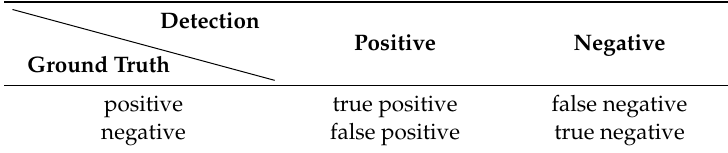
Table 2. Performance confusion